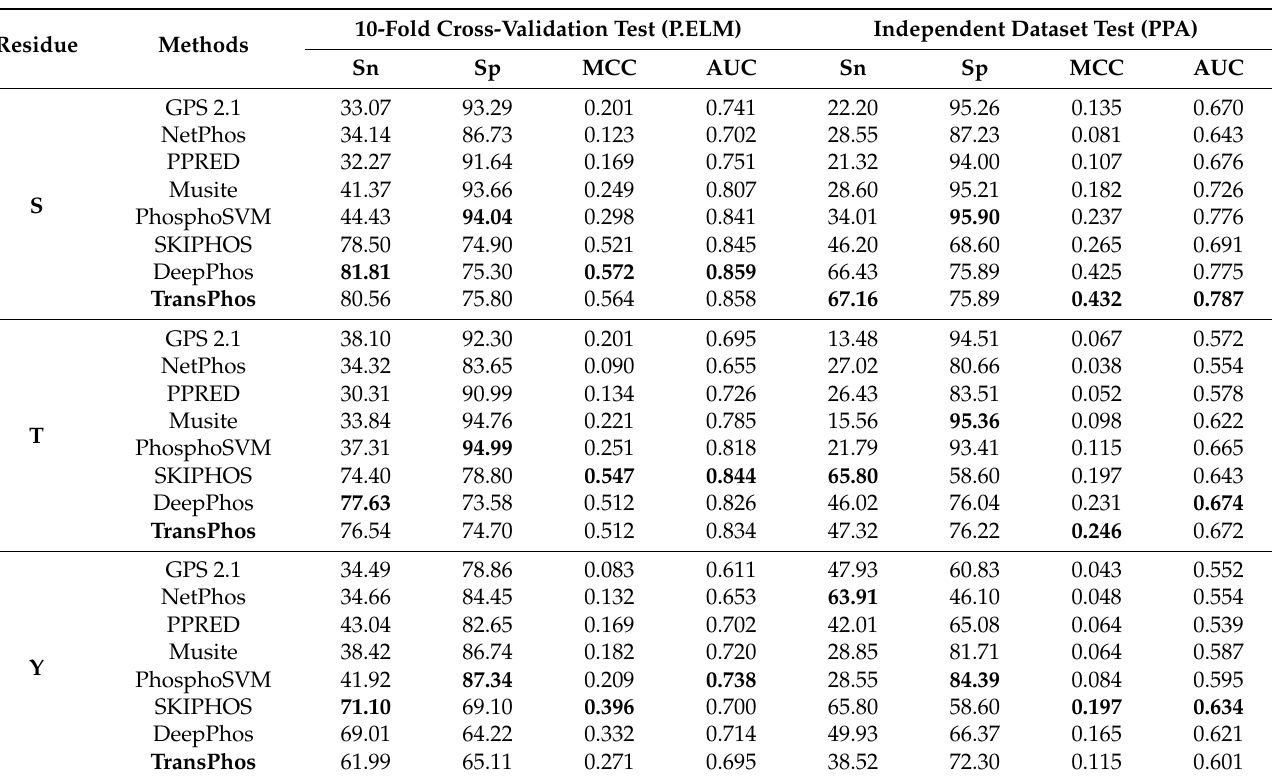
Table 3. Performance comparison with other predictors on training and independent datasets.